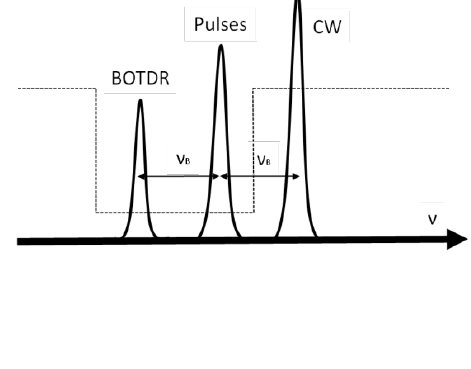
Figure 8. BOTDA signal filtering by means of a transmissive FBG represented by the dashed line.